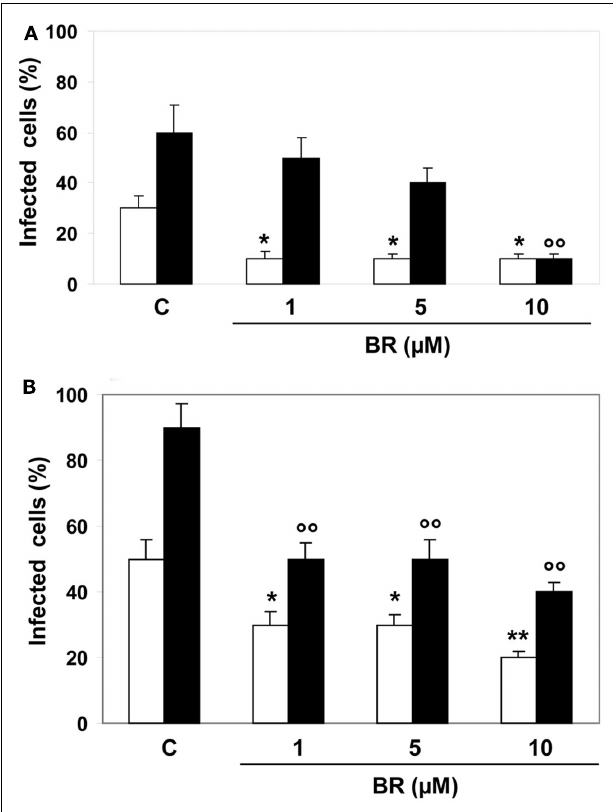
FIGURE 4 | Effects of bilirubin (BR) on cell monolayers infected with herpes simplex virus type 1 (HSV-1) and enterovirus EV71. After 2h of infection with HSV-1 and enterovirus (1 × 10 5 PFU), Hep-2 (A) andVero (B) cell monolayers were treated with BR (1–10 μ M) for further 2h. At the end of incubation the inocula were removed and the cells incubated in culture medium for 24 (white columns) or 48h (black columns). Data are expressed as the percentage of infected cells, mean ± SEM of six individual samples per group. * P < 0.05 and ** P < 0.01 versus control (C) after 24h from infection; ˚˚ P < 0.01 versus control after 48h from infection.